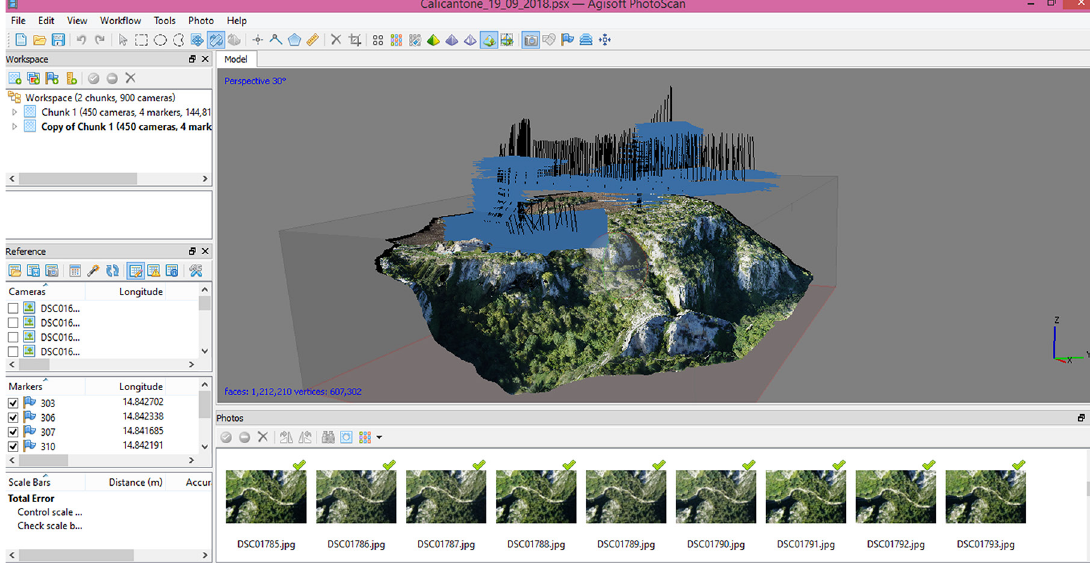
Figure 8. Preparation of the shooting scene for the UAV flight through the positioning of 9 ground control points.